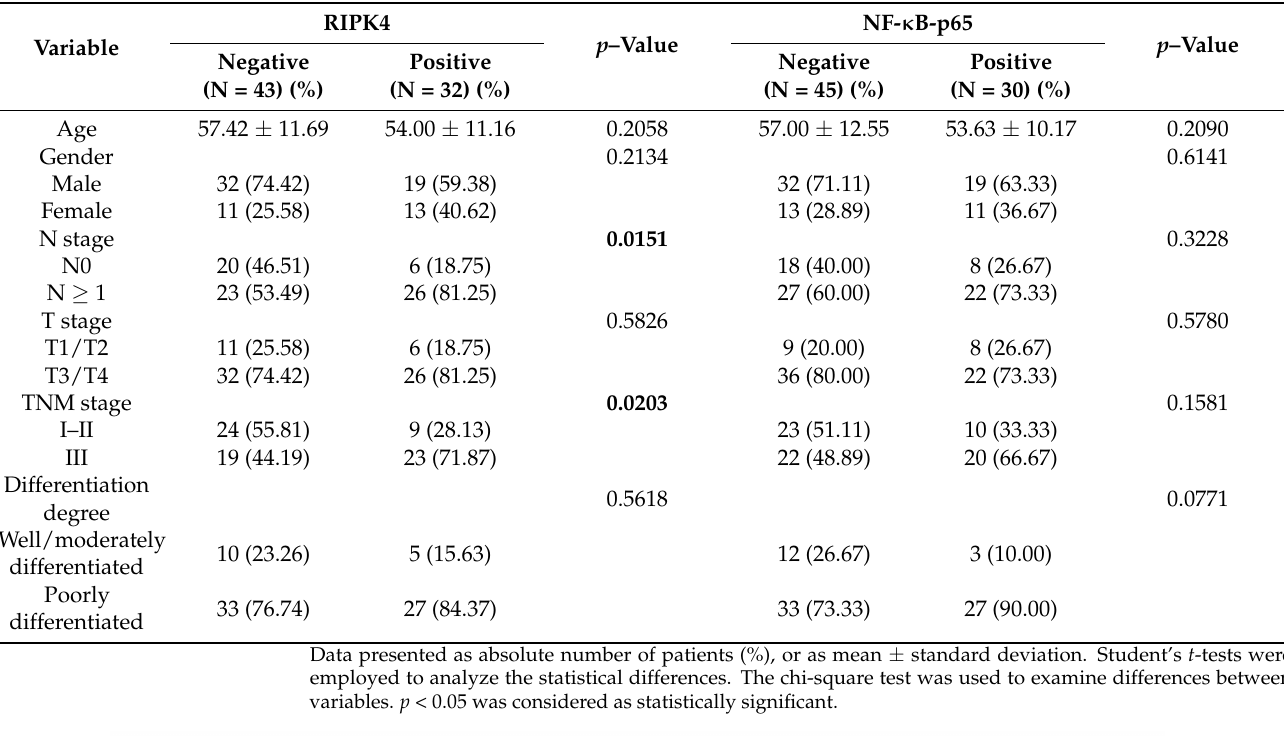
Table 2. The clinic-pathological factors of GC patients based on the expressions of RIPK4 and NF- κ B-p65.